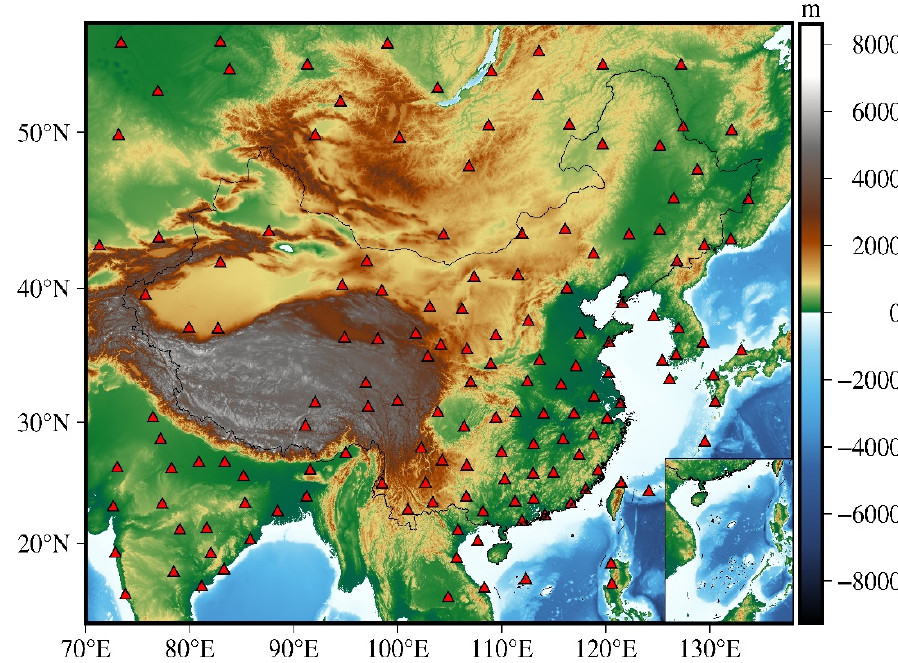
Figure 1. Study terrain and distribution of radiosonde stations (marked with red triangles).